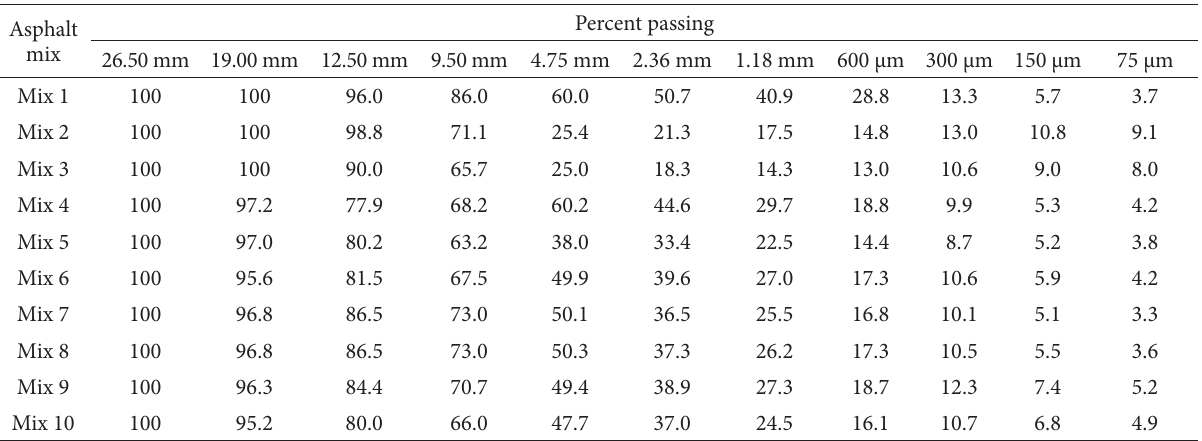
Percent passing